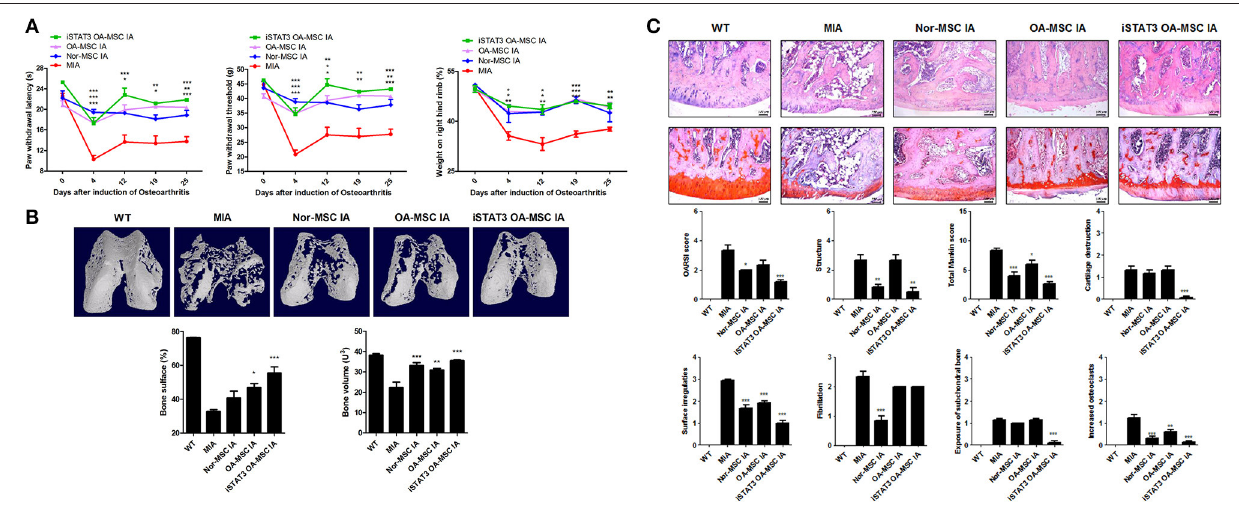
FIGURE 2 | Reduced severity by IA administration of iSTAT3 OA MSCs in MIA-induced OA rats. (A) OA was induced in Wistar rats by IA injection of MIA. OA Rats were injected with IA of normal (Nor-) MSCs (6 × 10 5 ), OA-MSCs (6 × 10 5 ), or iSTAT3 OA-MSCs (6 × 10 5 ). Nor-MSC were isolated of fat tissues obtain from each 2 normal person, and OA-MSC were from each 4 person with OA. Pain behavior was assessed as mechanical hyperalgesia measured with a dynamic plantar esthesiometer and incapacitance meter, and was quantified as PWL and PWT ( n = 3 per group). (B) Representative micro-CT images of the femoral condyles at 4 weeks in all groups. Object volume (Obj.V) and bone surface (%) were measured in micro-CT images from femurs. (* P < 0.05, ** P < 0.01, *** P < 0.001). (C) Histochemical analysis of Femoral condyle and severity scores after IA administration of iSTAT3-OA MSCs to MIA-induced OA rats. Knee joint tissue samples were acquired from all OA groups at 4 weeks and stained with H&E and Safranin O to evaluate the severity of inflammation and cartilage damage (* P < 0.05, ** P < 0.01, *** P < 0.001).